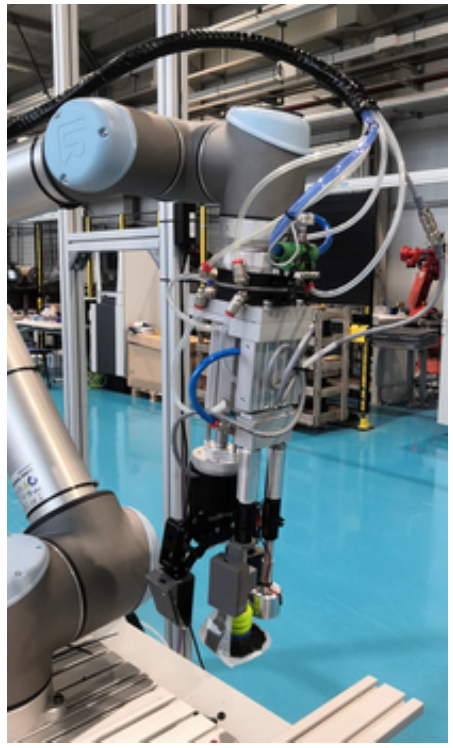
Figure 2. Multi-functional gripper attached to the UR